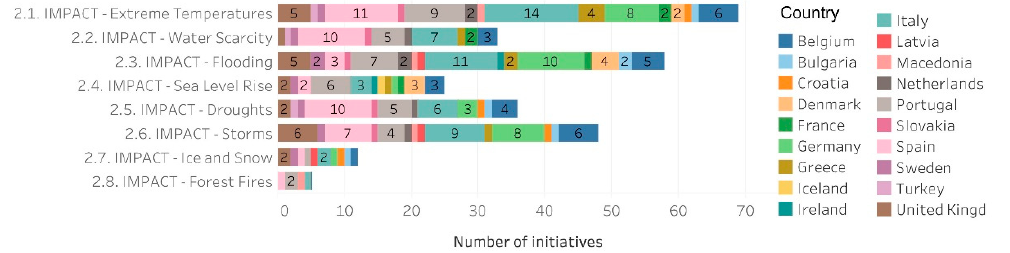
Figure 3. Distribution by country of Climate Impact. Source: Compiled by the authors from Mayors Adapt information [19].